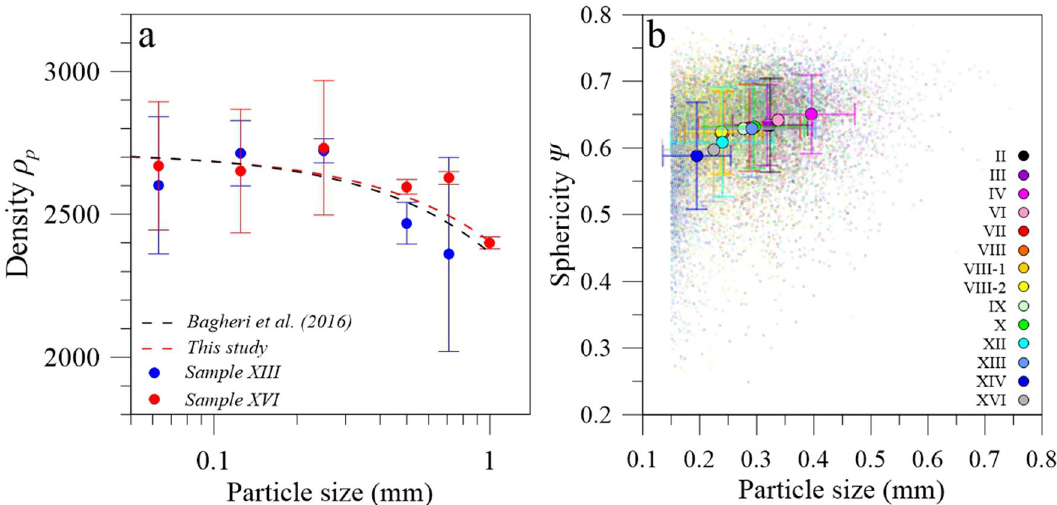
Figure 2. ( a ) Semi-log plot of particle densities ρ p (kg m −3 ) determined by water pycnometry as a function of particle sizes (mm). Blue and red dots correspond to particles from samples XIII and XVI, respectively. Black and red dashed lines corresponds to density best fits obtained by Bagheri et al. 22 and considering our data, respectively (see main text for more details). ( b ) Particle sphericities Ψ 36 determined with the BTS for all analyzed fractions of each tephra sample (small colored dots). Larger circles and error bars indicate the mean sphericity of each analyzed sample and its standard